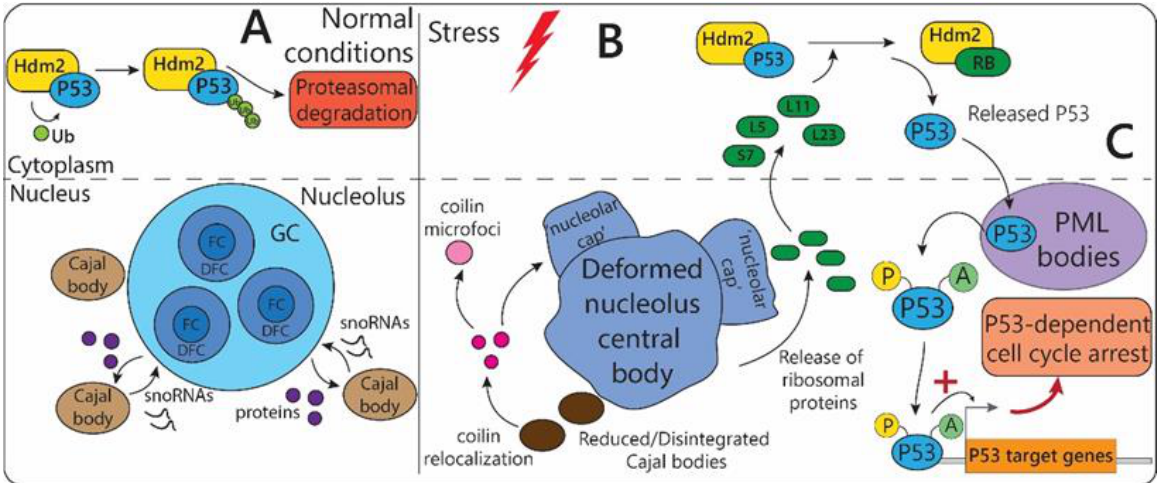
Figure 2. Functional and structural changes in nucleolus and Cajal bodies in response to